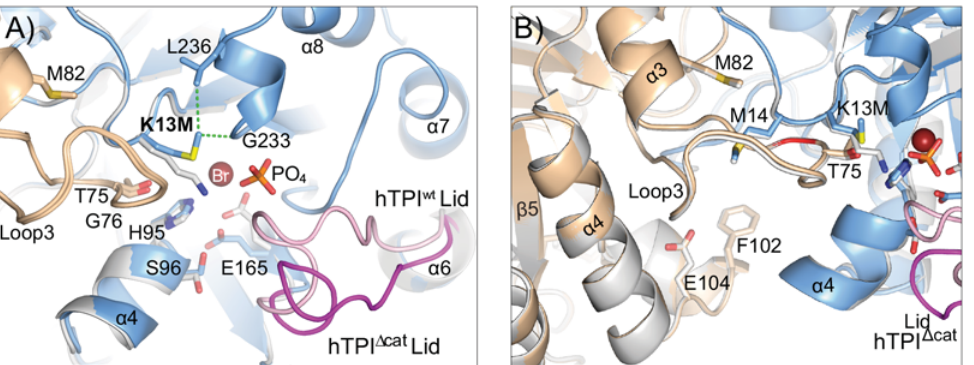
Fig 5. hTPI Δ cat crystal structure reveals a catalytically incompetent enzyme with an unaltered dimer interface. (A) The hTPI Δ cat adopts an open lid conformation. Superposition of hTPI WT (grey) and hTPI Δ cat (blue) structures. Loop3 (tan), the position of the lid covering the TPI active site (magenta and pink), and the locations of bromide and phosphate ions from the active site pocket of hTPI WT are indicated. New hydrophobic interactions that help to reposition M13 are shown (green). (B) The dimer interface of hTPI Δ cat is unchanged relative to hTPI WT . Superposition of hTPI WT (grey) and hTPI Δ cat shown as in (A), with monomer subunits of hTPI Δ cat dimer in blue and tan. Key dimer interface residues and loops are indicated.